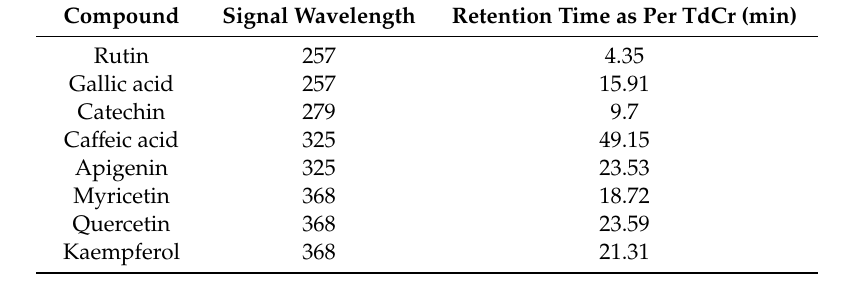
Table 1. Retention time of detected components in TdCr extract in comparison with reference flavonoids determined by HPLC-DAD analysis.